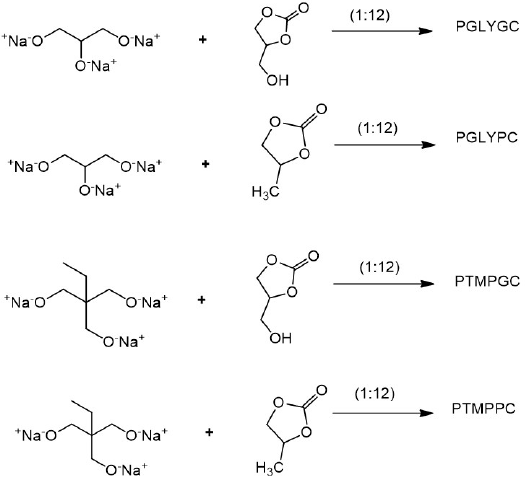
Figure 1. Reaction representation of the obtained polymers with respective core and monomers in the ratio